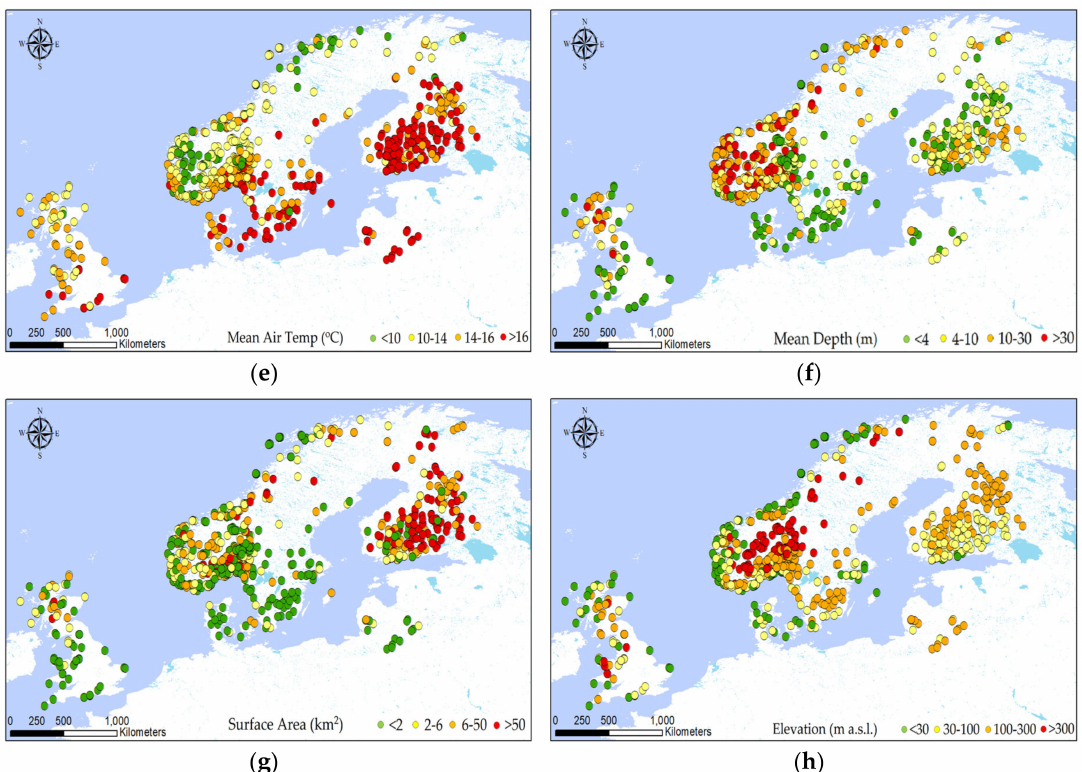
Figure 2. Spatial distribution of the biochemical and geomorphological variables across the subset of the WISER lakes database: ( a ) cyanobacteria biomass (CBB); ( b ) Chl-a; ( c ) total nitrogen (TN); ( d ) total phosphorus (TP); ( e ) mean air temperature; ( f ) mean depth; ( g ) surface area; ( h ) elevation. All variables correspond to the record with the maximum CBB concentration for each lake.